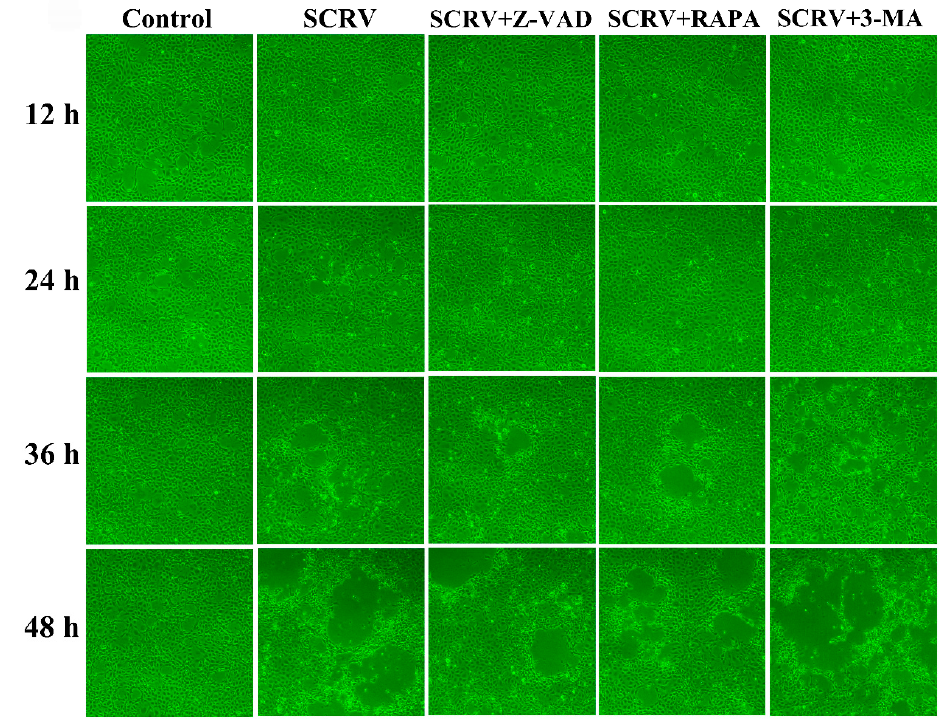
Figure 5. CPE observation of SCRV-infected EPC cells after co-incubation with different chemical (3-MA, Z-VAD and RAPA). Rapamycin could postpone the progress of CPE induced by SCRV at different time points. (Original magnification, ×100).